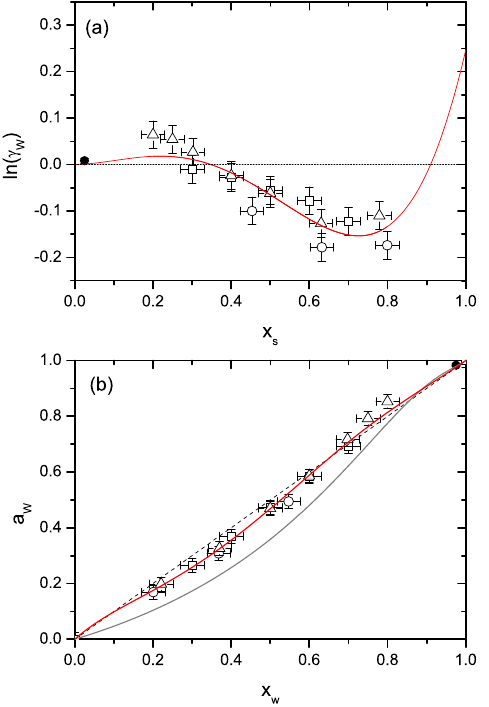
Figure 6. (a) Natural logarithm of water activity coefficient γ w vs. mole fraction of shikimic acid, symbols are data for three indepen- dent particles, solid circle is the bulk data point, dashed line repre- sents ideal behavior (Raoult’s law), red line is the fit of Eq. (5) to the data. (b) The same data plotted as water activity vs. mole frac- tion of water, the gray line is the prediction of the thermodynamic model AIOMFAC (Zuend et al., 2011).